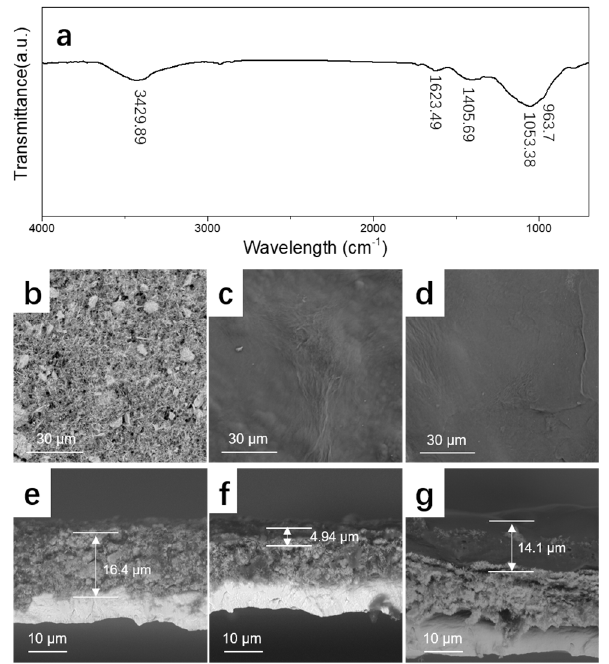
Figure 2. ( a ) FTIR spectrum of agar; SEM image of α‐ MnO 2 ( b , e ), MnO 2 ‐ 1 ( c , f ), and MnO 2 ‐ 2 ( d , g ).